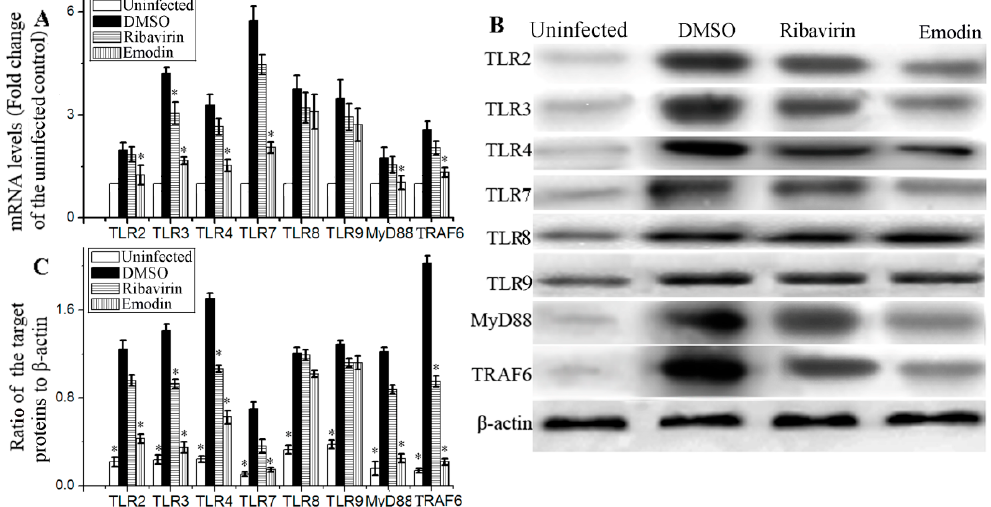
Figure 2. Effect of emodin on the expressions of TLRs, MyD88 and TRAF6 after IAV infection. In the uninfected group (Uninfected), A549 cells were not infected with IAV (ST169). In the negative control (DMSO), positive drug control (Ribavirin) and emodin-treated (Emodin) group, A549 cells were infected with IAV (MOI = 0.001) and treated with 0.5% ( v / v ) DMSO, ribavirin (25 µ g mL − 1 ) and emodin (25 µ g mL − 1 ), respectively. After 48 h p.i., the cells were harvested. ( A ) The results of qRT-PCR assay; ( B , C ) The results of western blotting assay. All data shown were mean ± SD of five independent experiments. n = 5, * p < 0.05 vs. the DMSO control.